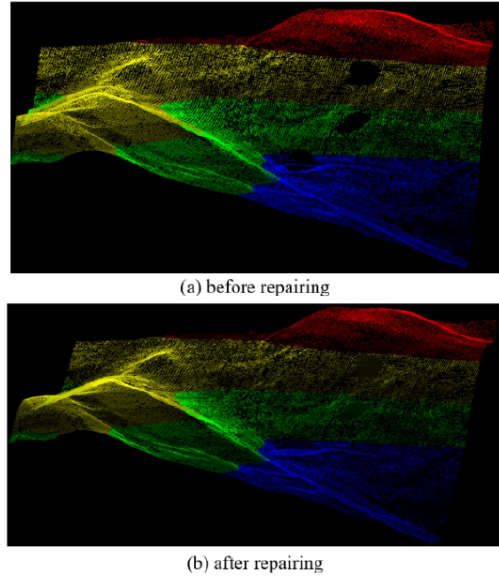
Figure 5. Hole repair